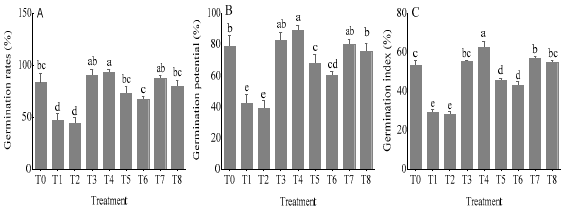
Figure 3. Effects of T. longibrachiatum (TL6 and TL3) on snow pea seeds’ ( A ) germination rate, ( B ) germination potential, and ( C ) germination index for F. solani (FSH) and F. avenaceum . Data are presented as mean ± standard errors (SE) of two independent experiments in three replicates. Means with the same lowercase letters are not significantly different at p < 0.05, according to Duncan’s multiple range